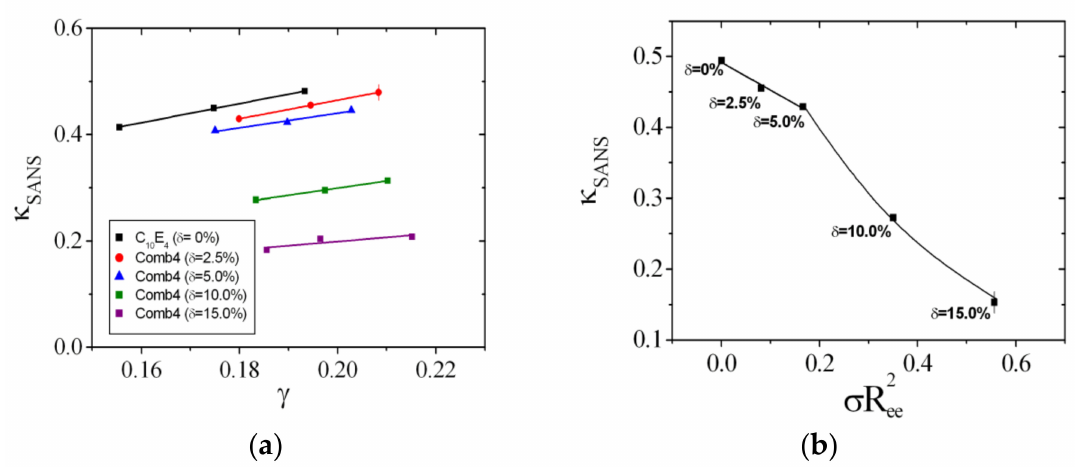
Figure 8. ( a ) The collection of bending rigidities from SANS experiments in units of k B T . The rightmost data point of the δ = 2.5% series indicates the typical error bar. ( b ) The dependence of the bending rigidity from SANS experiments on the scaled polymer amount. The slope can be used to determine the sensitivity Ξ SANS . The rightmost data point indicates the typical error bar.